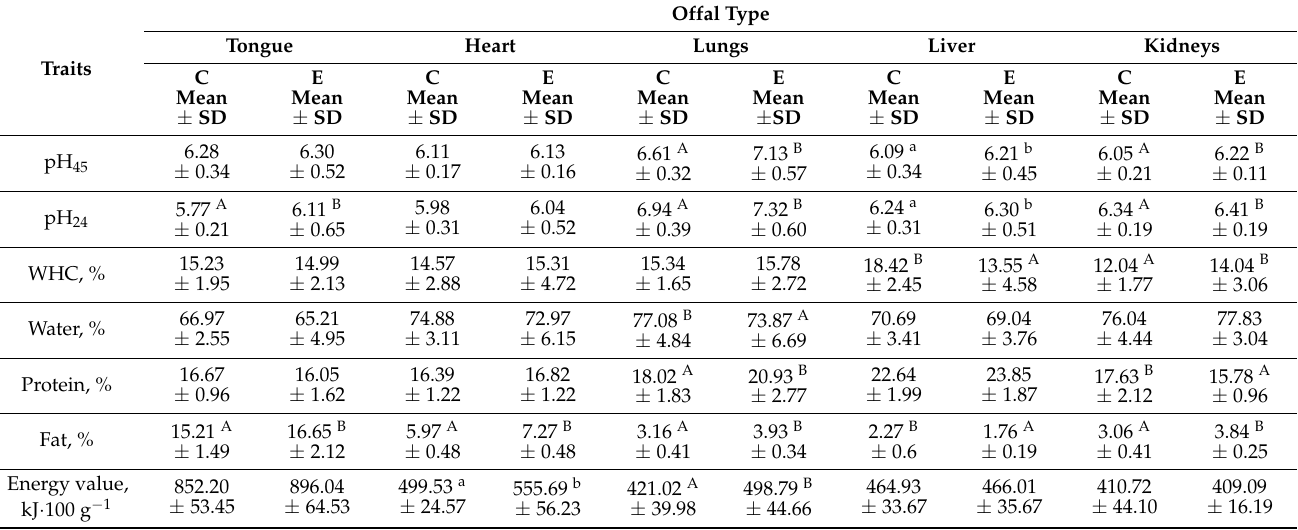
Table 5. Physical parameters, chemical composition and caloric content of the